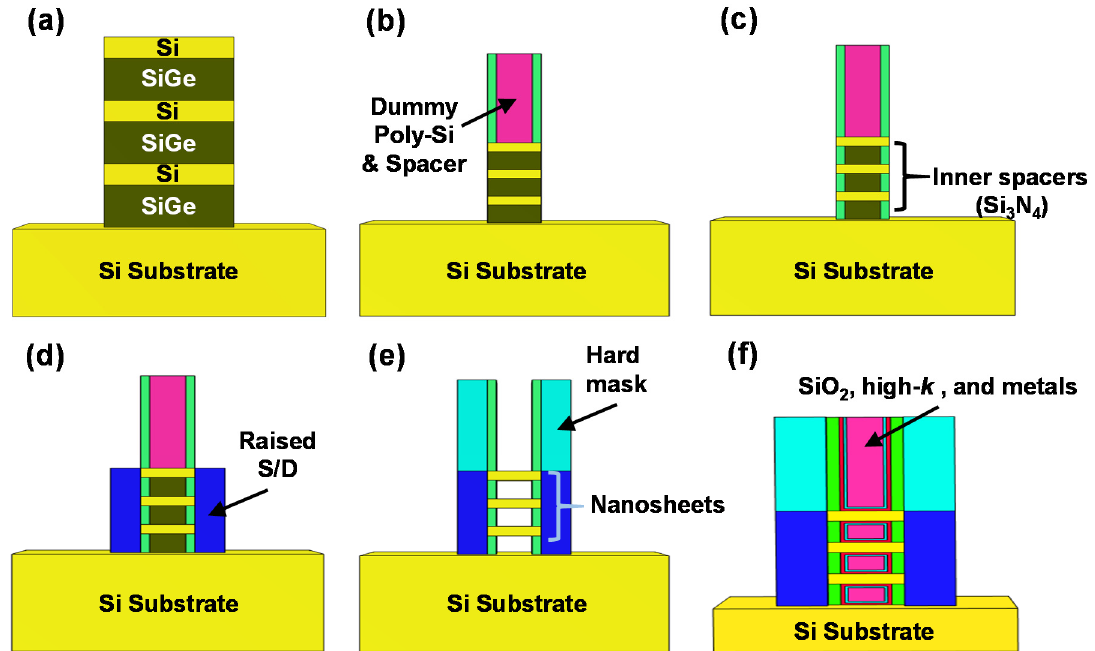
Figure 1. Summary of fabrication process flow of nanosheet FETs (NMOS). ( a ) Si/Si x Ge 1 − x stacking by iterative epitaxial growth. ( b ) Dummy poly-Si gate patterning and source/drain dry etching. ( c ) Si/Si x Ge 1 − x in-dent etching and inner spacer deposition. ( d ) Epitaxial growth for source and drain. ( e ) Replacement of poly-Si gate and channel-release by selective dry etching. ( f ) Gate stack formation including high-k, dipole engineering, and work function metals.